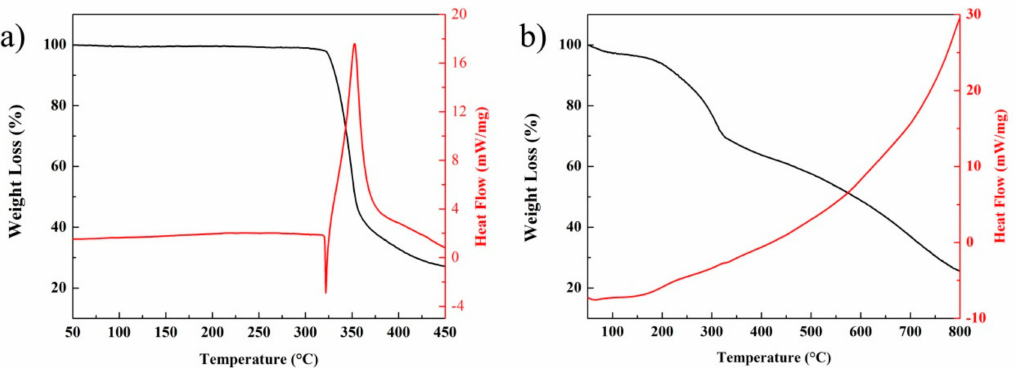
Figure 8. TG-DSC curves of the samples: ( a ) raw HNS and ( b ) nanoenergetic HNS derivatives in N 2 air flow and a heat rate of 10 ◦ C min − 1